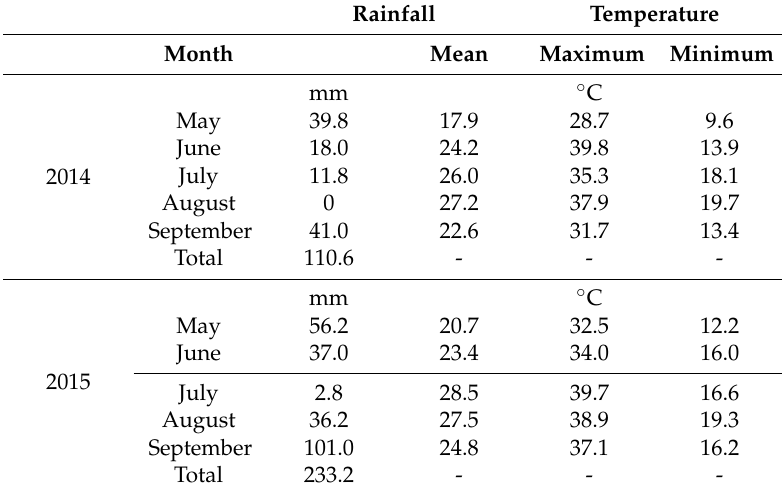
Table 3. Mean monthly rainfall and temperatures (mean, maximum and minimum) at the field experiment site in 2014 and